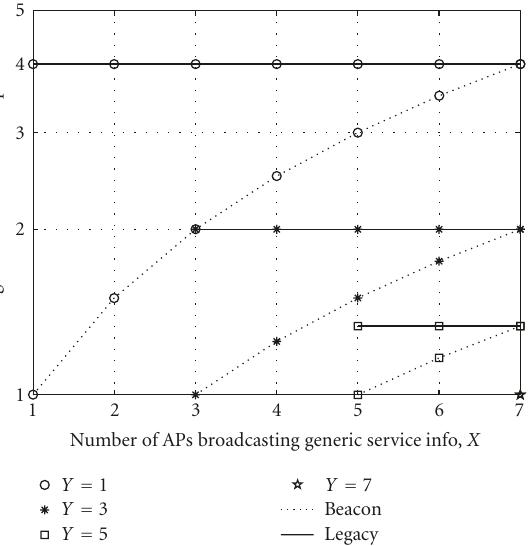
Figure 7: Average number of attempts to find the desired service in the beacon-based and try-and-see (legacy)